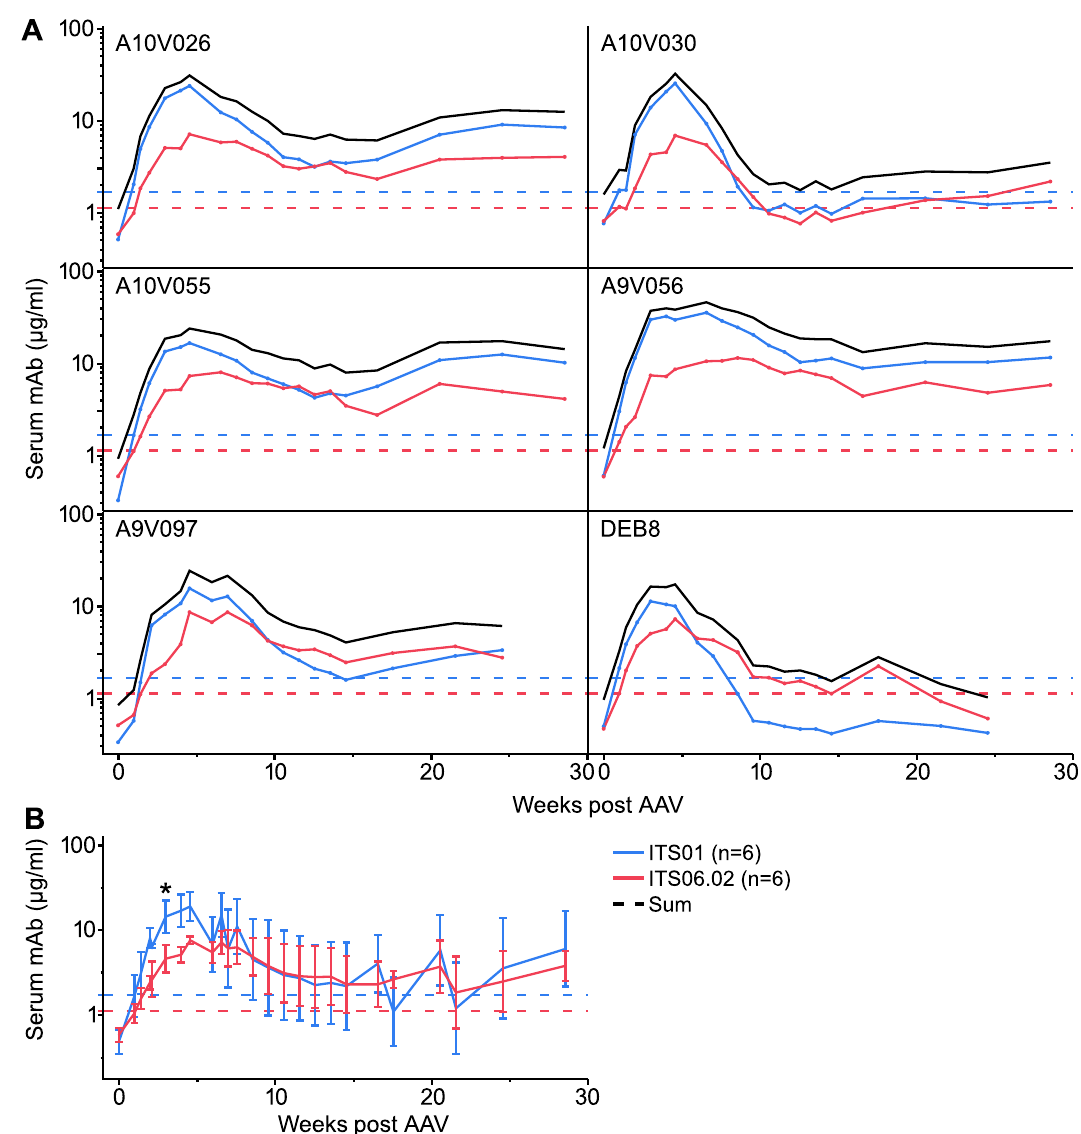
Fig 1. Stable transgene mAb expression following AAV8 administration in NHP. Rhesus macaques were injected with both AAV8-ITS01 and AAV8-ITS06.02 at 1 x 10 13 gc/mAb/animal in the right and left quadriceps, respectively. (A) Serum ITS01 (blue lines) and ITS06.02 (red lines) and their sum (black lines) are shown individually for each animal over time following injection. (B) The average and standard deviation of expression levels are shown across all animals. Dashed lines indicate the lower limit of detection by binding to SIVmac239 gp140 (2 standard deviations above negative control sera) for ITS01 (blue), ITS06.02 (red). Asterisks denote statistically significant difference between mean ITS01 and ITS06.02 expression at week 4 (p � 0.05).